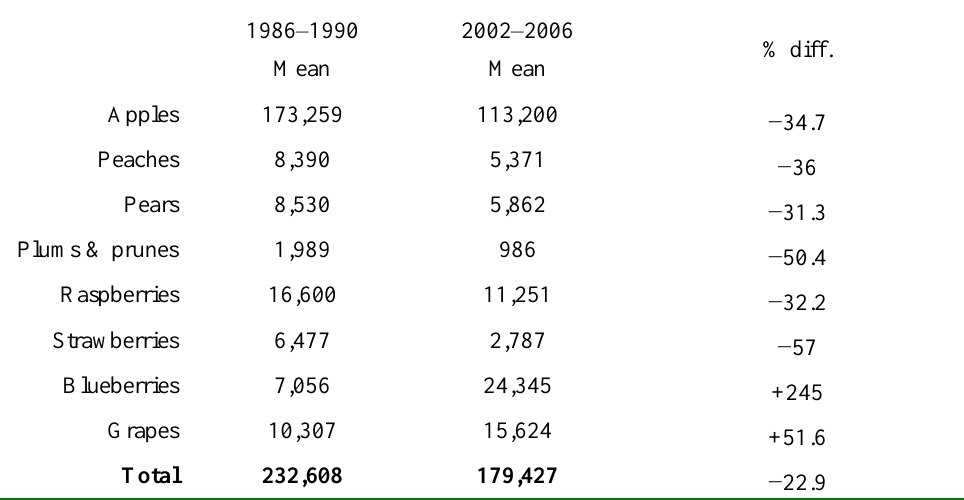
Table 5. Summary Statistics, Changes in BC Fruit Production, 1986–2006.